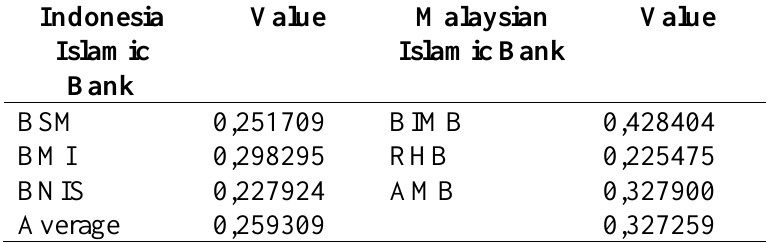
Table 12 Comparison Of Maqashid Sharia On Indonesian Islamic Banks and Malaysian Islamic